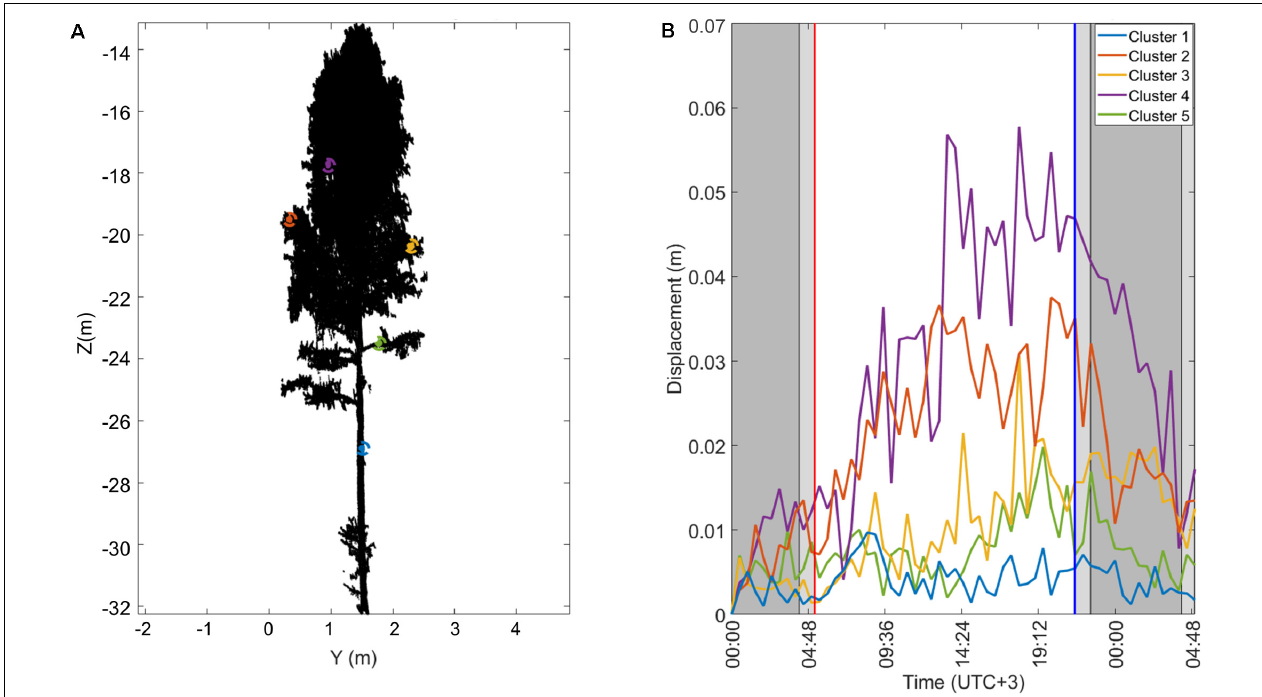
FIGURE 9 | An example of a 30-h-long circadian rhythm monitoring period in a Silver birch tree between April 30 12 A.M and May 01, 2020 05:00 A.M using the TLS measurement station data. (A) Three segmented clusters selected from the stem and branches. (B) Selected cluster center displacements from the initial locations.